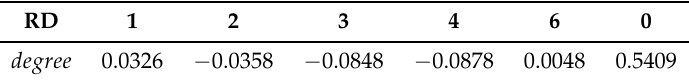
Table 5. Calculation results of